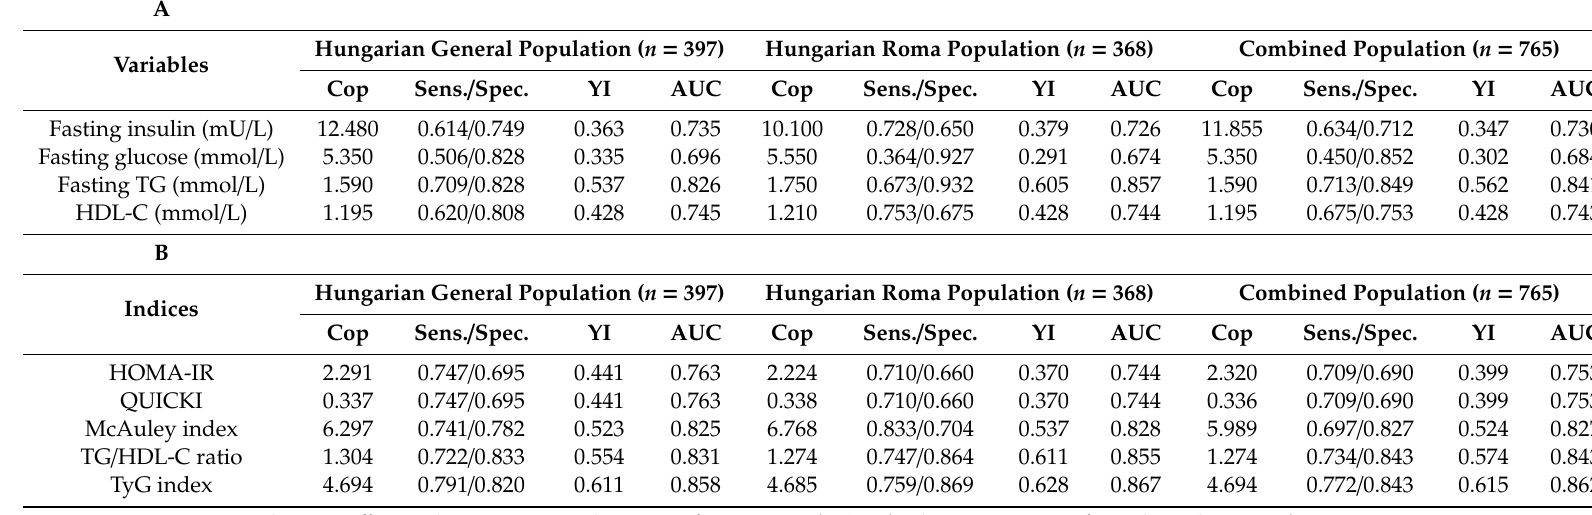
Table 5. The cut-o ff points and their sensitivity, specificity and Youden’s index calculated on the basis of area under curve for each surrogate measure—as biochemical parameters ( A ) and indices ( B )—in the Hungarian general and Hungarian Roma populations and in the combined study